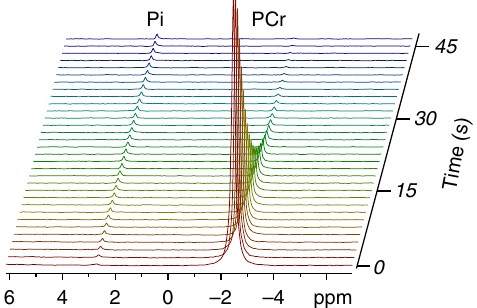
Fig. 4 31 P spectra of hyperpolarized PCr in D 2 O containing 50 mM phosphate buffer (pH 7.4). The Pi signal is shown to increase over time and then plateau. This is due to the magnetization of the Pi 31 P nuclei from the dissolution media (not hyperpolarized), reaching steady state at thermal equilibrium in the magnetic fi eld of the spectrometer. The hyperpolarized PCr signal decays with time to thermal equilibrium. The thermal equilibrium signal of PCr is undetectable in one scan due to its low concentration (2.78 mM). The chemical shift was assigned using the PCr signal at − 2.5 ppm 34 . Each spectrum was acquired with a nutation angle of 15° and the repetition time was 1.5